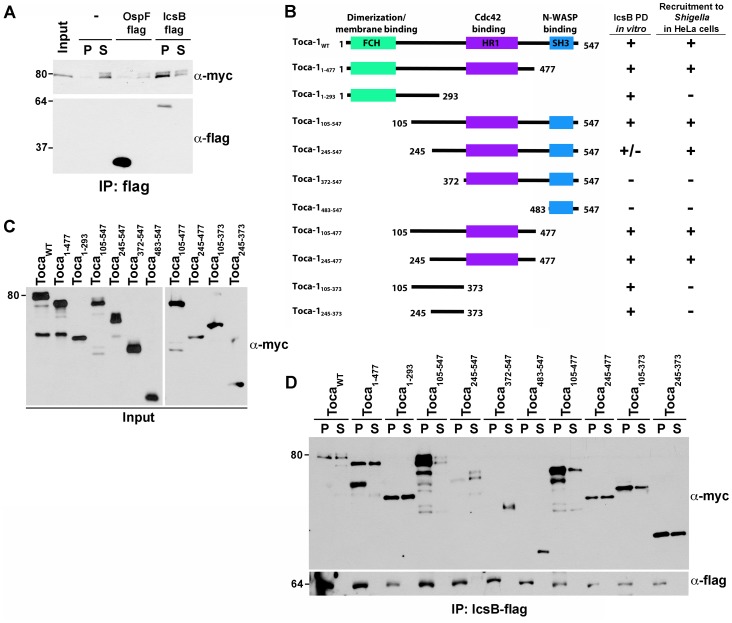
IcsB interacts with the HR1 and adjacent coiled coil region of Toca-1.(A) Immunoprecipitation of Myc-Toca-1 with IcsB-flag. Proteins secreted by S. flexneri strains carrying no plasmid, IcsB-flag, or OspF-flag were bound to anti-flag beads, which were then used to precipitate Myc-Toca-1 from cell lysates. Western blot analysis. Input, cell lysate. (B) Schematic of Toca-1 domain structure and truncation mutants, indicating pull down by IcsB in vitro and recruitment to wild type S. flexneri in cells. (C and D) Immunoprecipitation of Myc-Toca-1 and its truncation mutants with IcsB-flag, as in panel (A). (C) Input. Panels are from the same blot. (D) Precipitated proteins. Western blot analysis. P, pellet; S, supernatant.